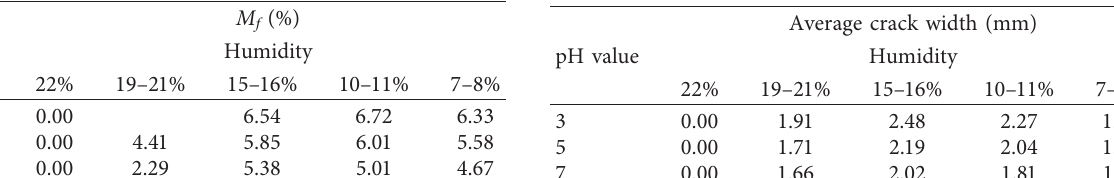
Table 4: The crack area ratio of the sample under four-time cyclic drying-wetting.